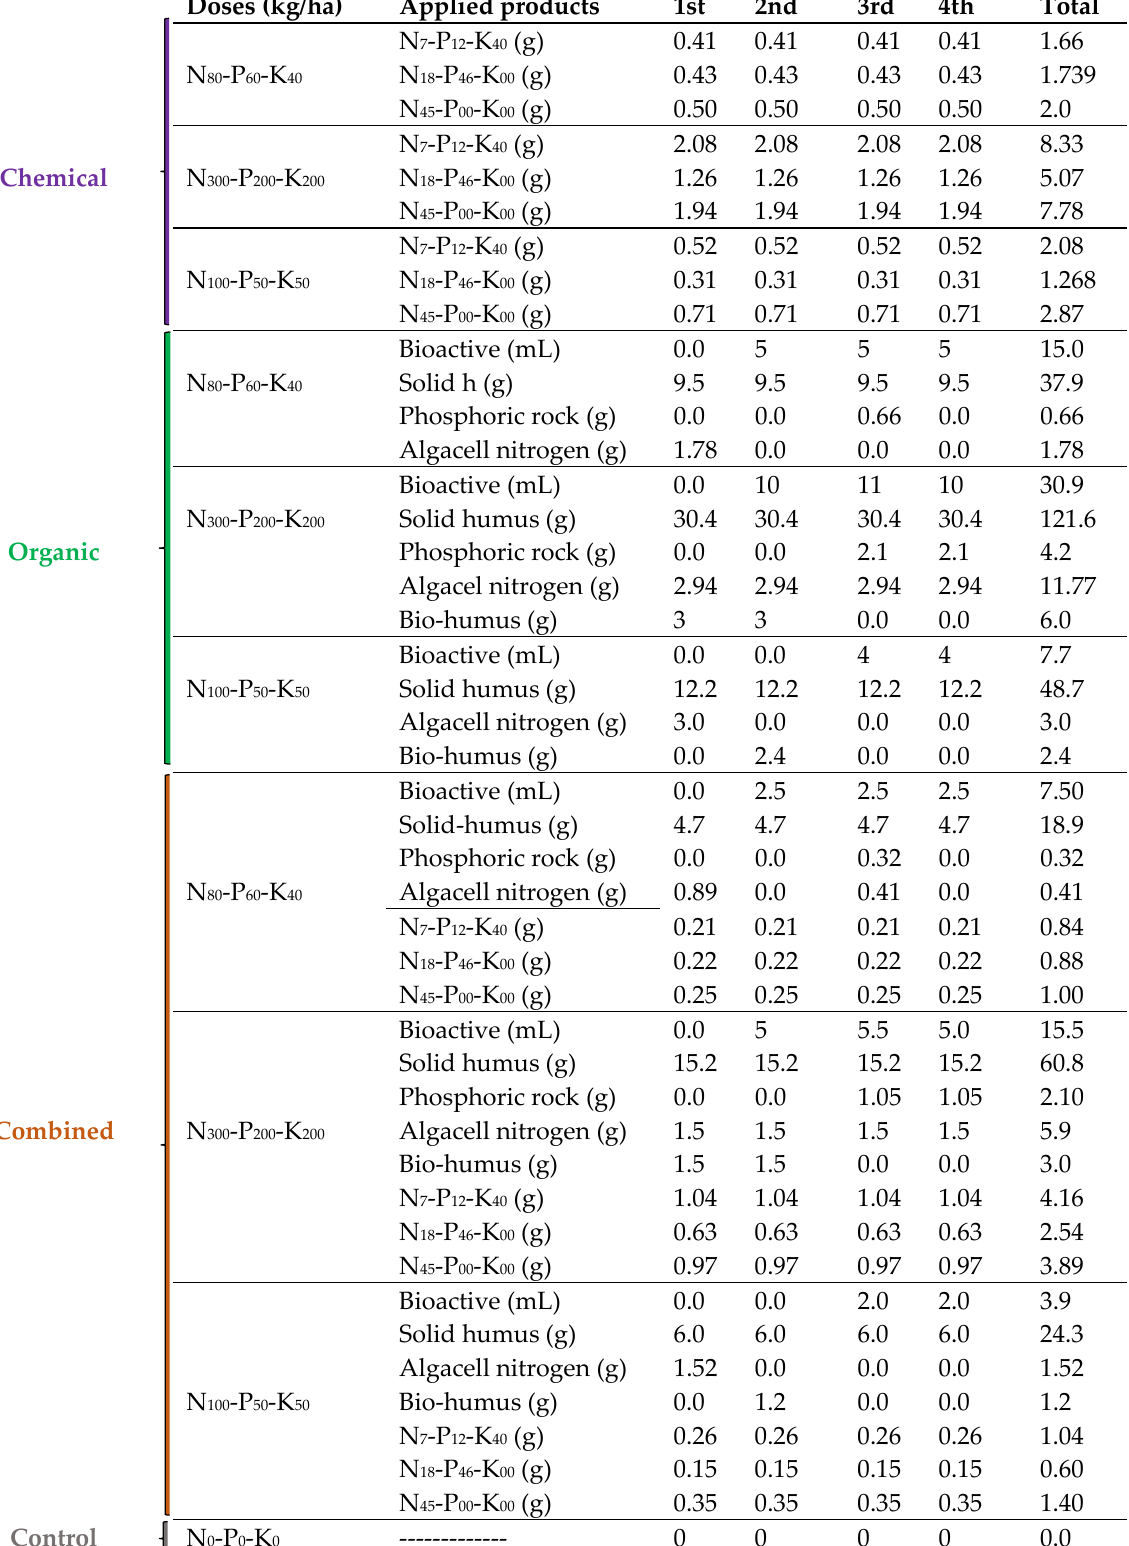
Figure 1. Treatments established for different fertilizer sources (chemical, organic, combined, and control), doses in tuberose, and applied products for four runs of each experiment.